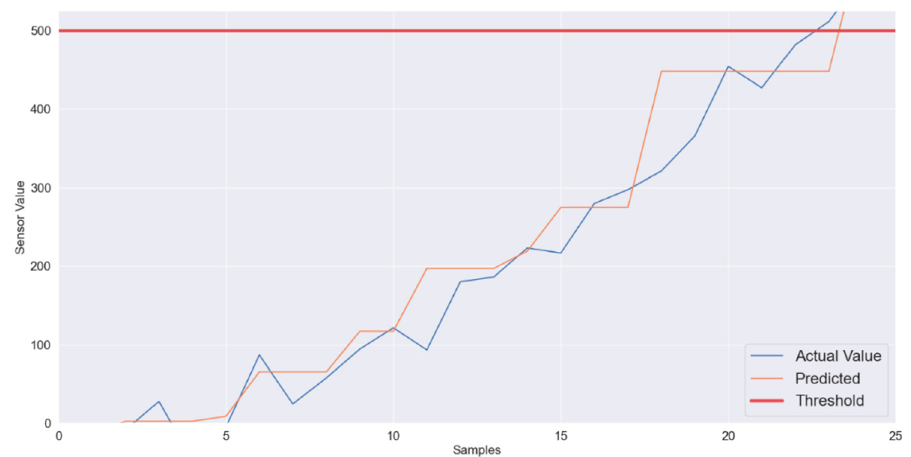
Figure 7. Rapidly changing sensory data.